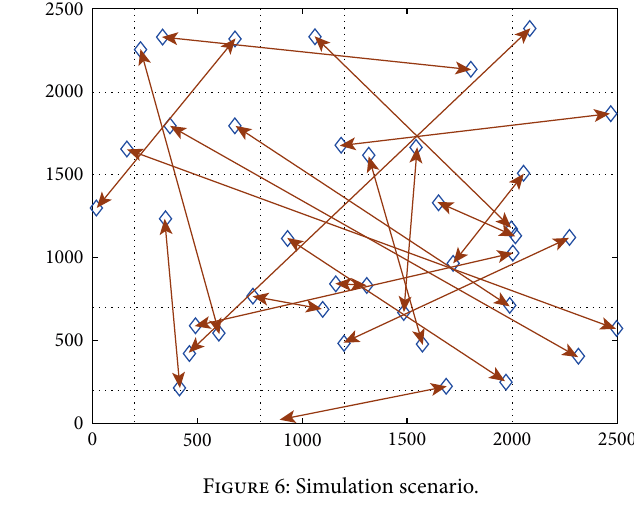
Figure 6: Simulation